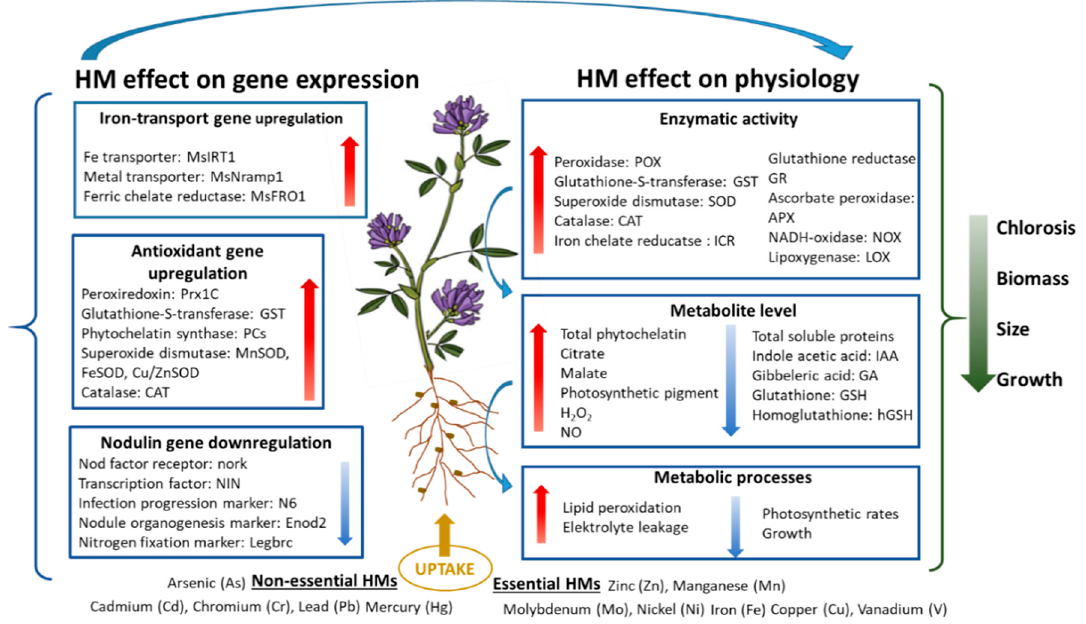
Figure 3. Effects of essential and non-essential heavy metals on alfalfa .